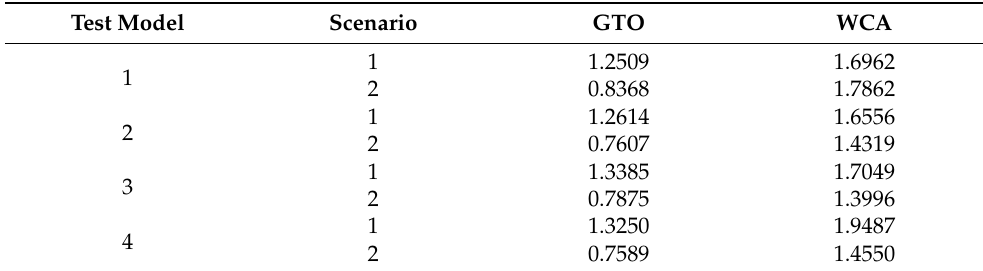
Table 14. GTO defense regarding the TOT in Agiba power network.